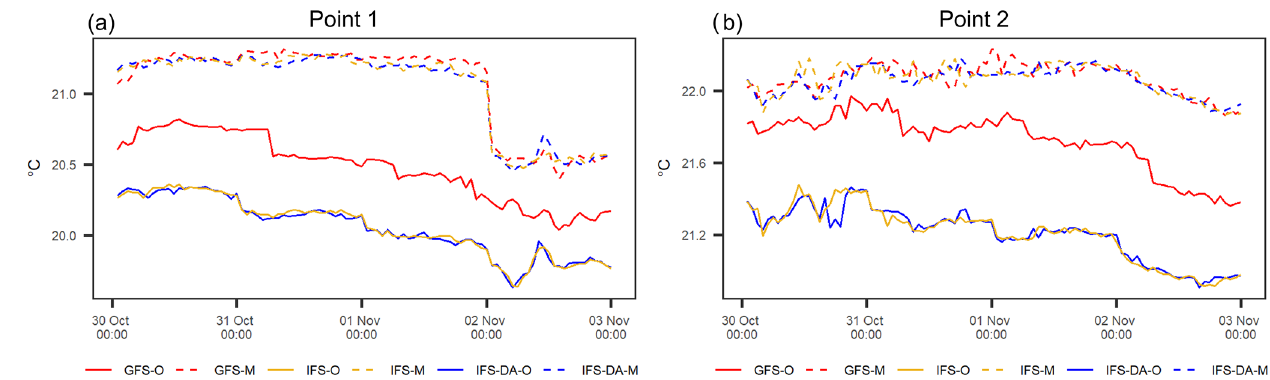
Figure 10. Case study 2: temporal evolution of SSTSK ( ◦ C) at points 1 and 2, as shown in Fig. 3b.